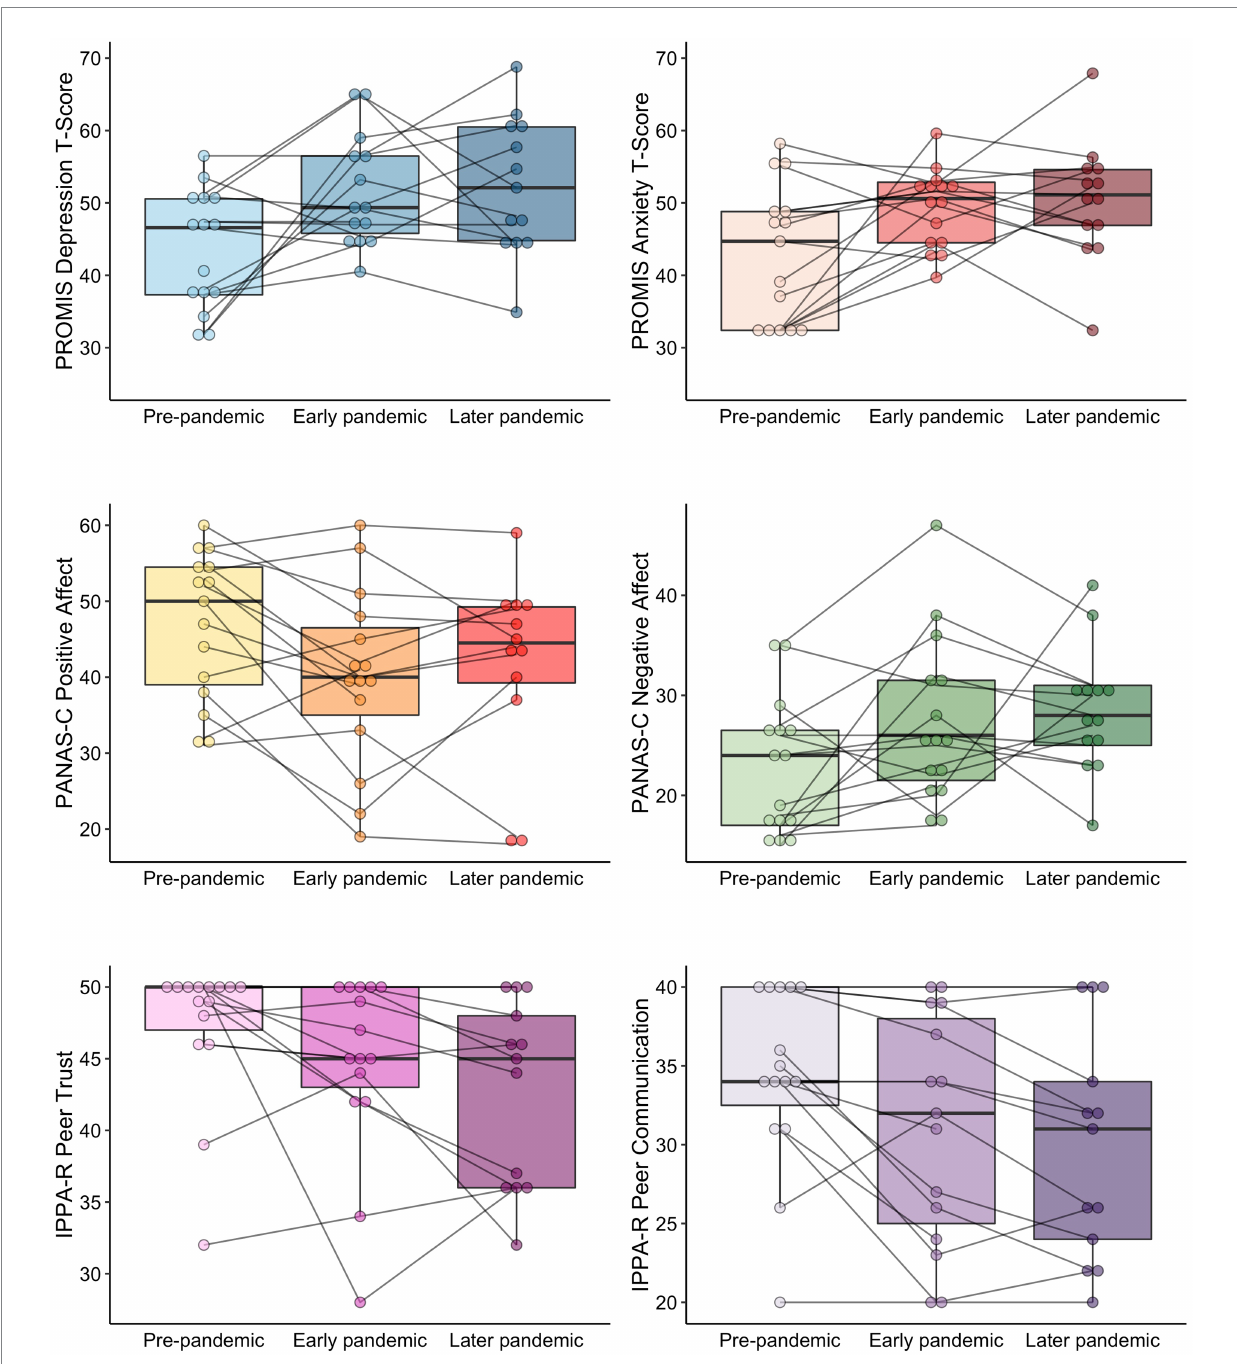
FIGURE 1 Individual and box plots of the primary and secondary outcomes across three time